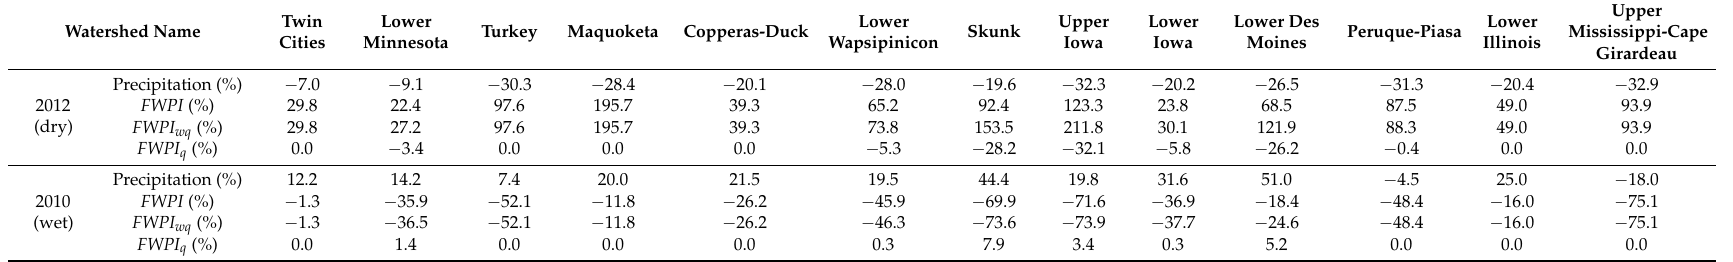
Table 4. Relative changes in precipitation, FWPI , FWPI wq , FWPI q in 2012 and 2010 compared to average values between 1995 and